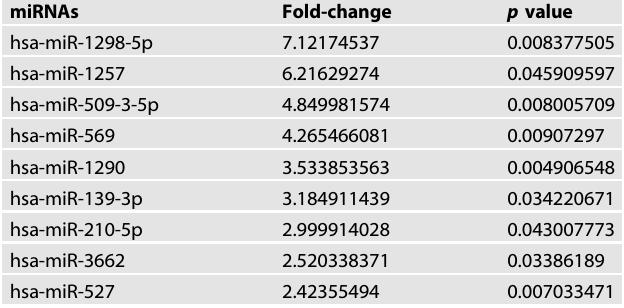
Fig. 2 Silencing of hsa_circ_0003222 blocked NSCLC cell proliferation and stemness. A RT-qPCR demonstrating hsa_circ_0003222 level in PC9 and A549 lung cancer stem cells (LCSCs). B CCK8 assays presented cell proliferation at different times. C , D Colony formation assay showing proliferation in LCSCs. E , F Spheroid formation was assessed in LCSCs. G – J Cells migration and invasion were detected by Transwell assay. K Western blot demonstrating CD44, CD133, OCT4, SOX2, and PD-L1 levels in LCSCs. L CCK8 assays presented cell proliferation in response to different concentrations of cisplatin. M Western blot demonstrating MRP1 and P-gp levels in LCSCs. Data were shown as mean ± SD; *** P < 0.001. Table 2. Upregulated miRNA in the si-circ2 PC9 cells compared to si-control PC9